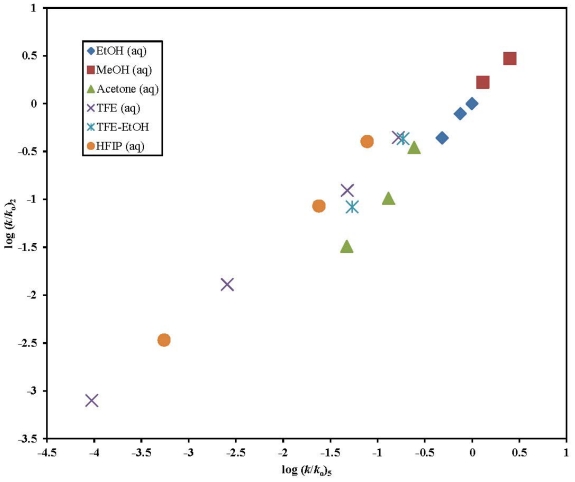
The plot of log (k/ko) for 2-methoxyphenyl chloroformate (2) against 4-methoxyphenyl chloroformate (5).